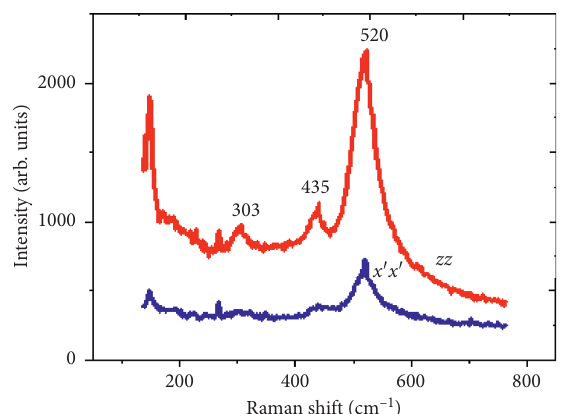
Figure 7: zz and x ′ x ′ polarized Raman spectra of (110)-oriented Zn doped PBCO thin film.